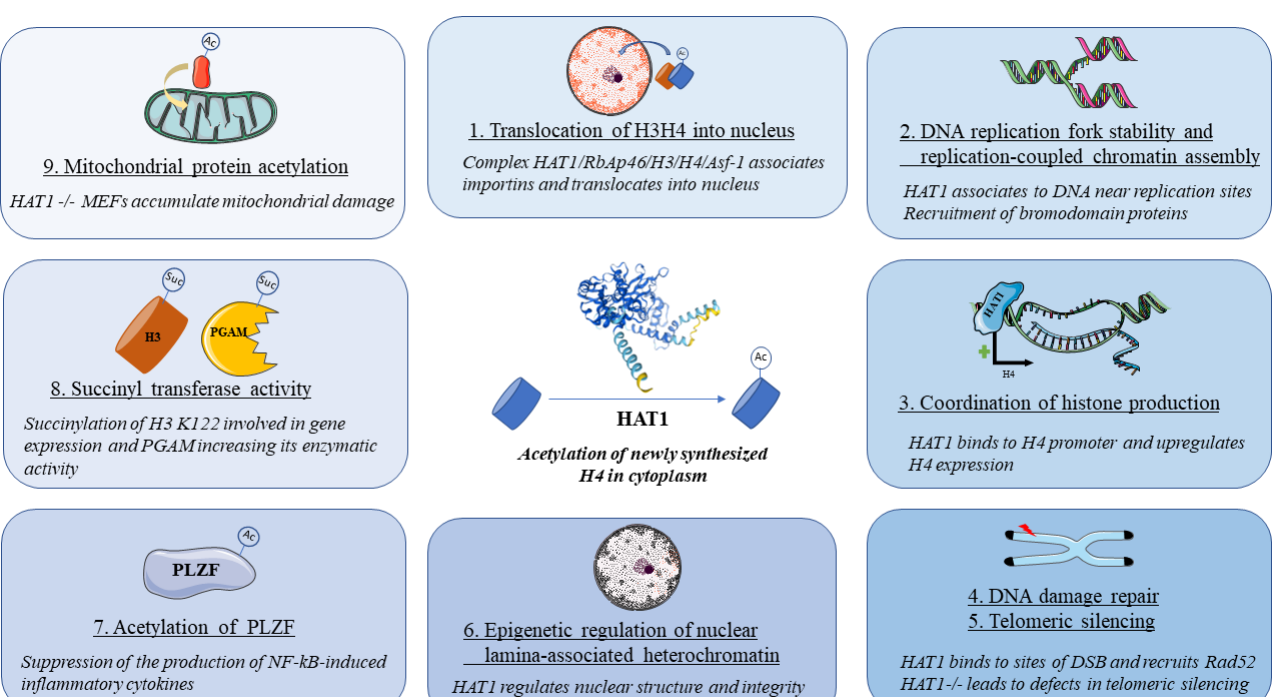
Figure 2. Overview of canonical and noncanonical functions of HAT1. Center: canonical role of HAT1 consists of the acetylation of newly synthesized H4 histones in the cytoplasm. Peripheral: non-canonical roles of HAT1 encompass: (1) Translocation of H3H4 into nucleus, (2) DNA replication fork stability and replication-coupled chromatin assembly, (3) Coordination of histone production, (4) DNA damage repair, (5) Telomeric silencing, (6) Epigenetic regulation of nuclear lamina- associated heterochomatin, (7) Acetylation of PLZF, (8) Succinyl transferase activity and (9) Mitochondrial protein acetylation. HAT1 = histone acetyltransferase 1, RbAp46 = pRB-associated protein p46, Asf-1 = anti-silencing factor 1, DSB = double-strand break, PLZF = promyelocytic leukemia zinc finger, PGAM = phos- phoglycerate mutase, MEF = mouse embryonic fibroblast.